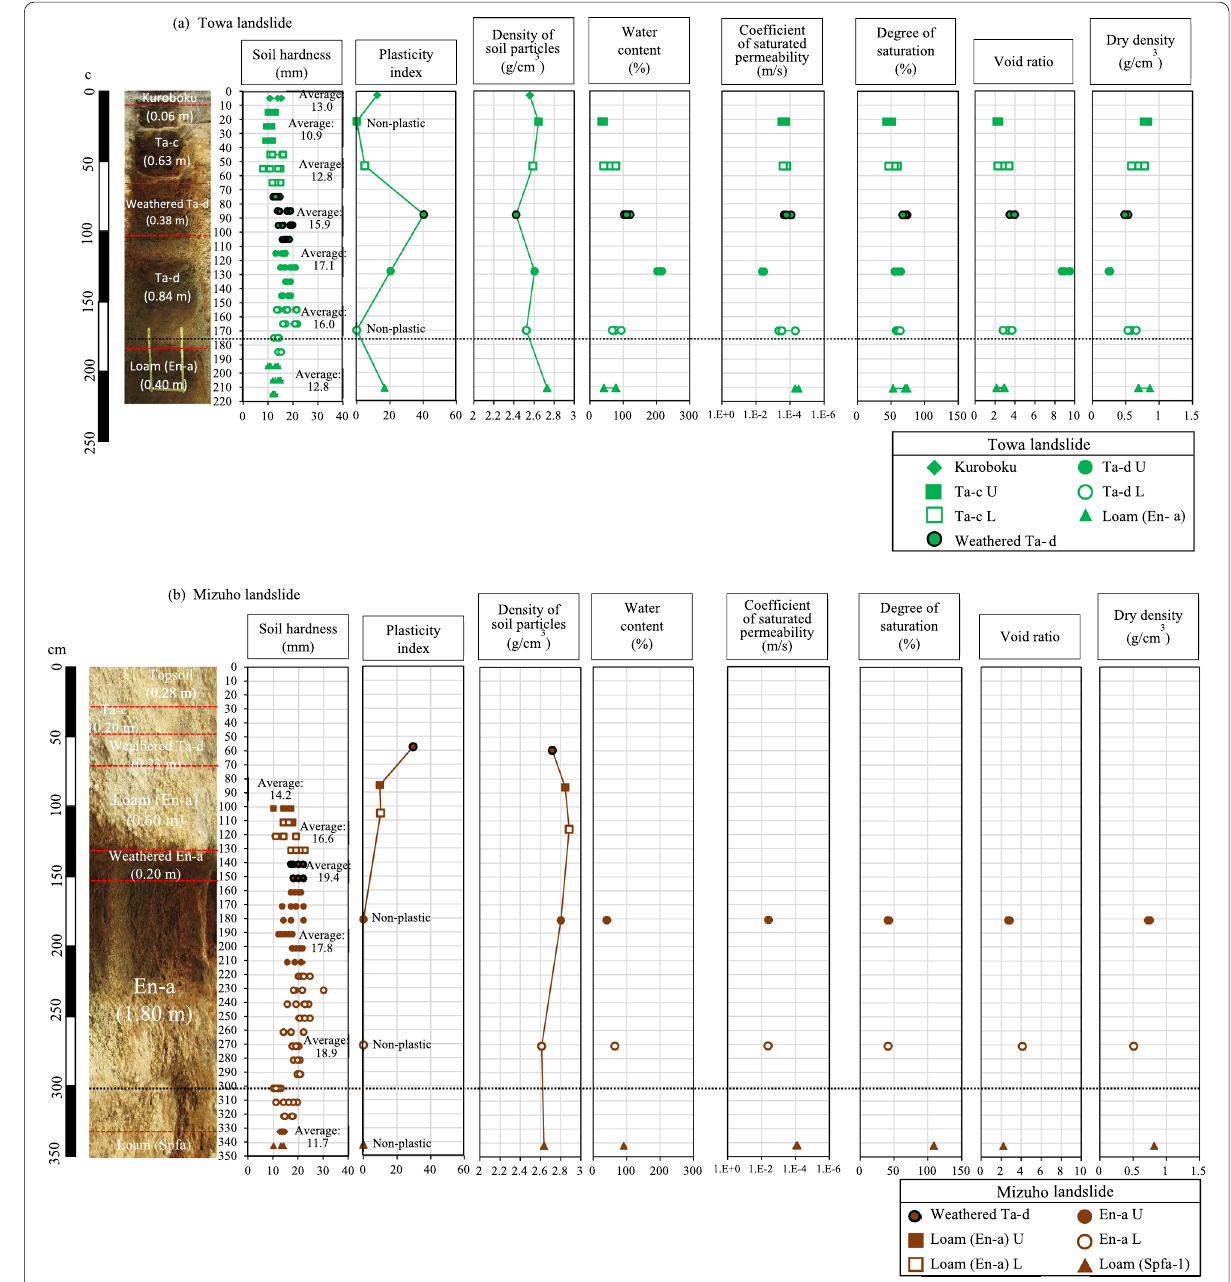
Fig. 5 Soil stratigraphy on the field, soil hardness, physical properties, and saturated permeability properties values in research area with dotted lines indicate sliding layer by field observation; a Towa landslide, b Mizuho